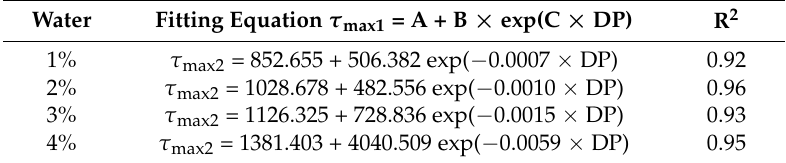
test.1 ( b ) X test.2